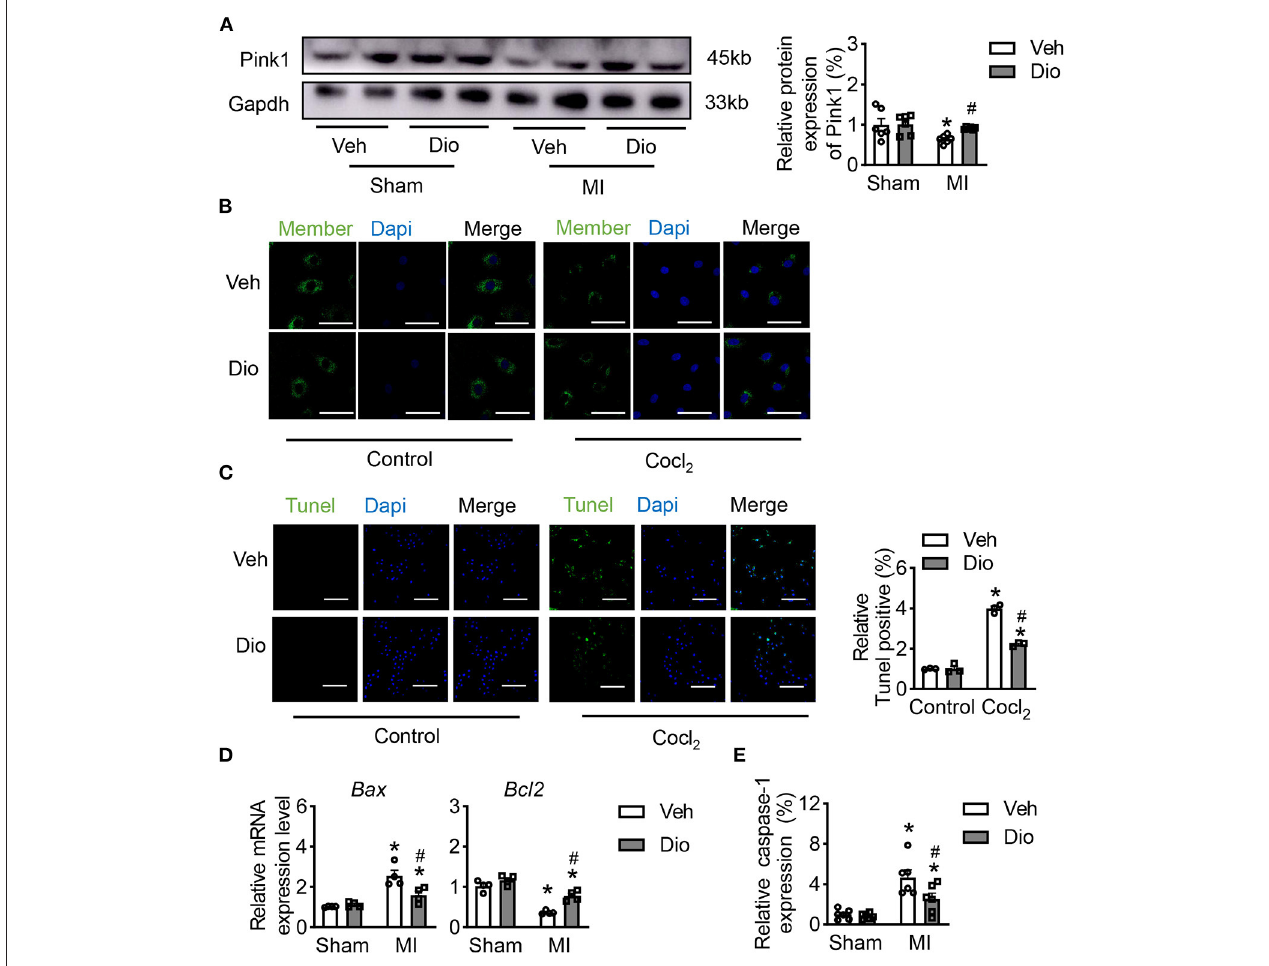
FIGURE 1 | Dioscin alleviates the mitochondrial injury by CoCl2 in H9C2 cells. (A) The protein level of Pink1 in heart tissue ( n = 6). (B) Representative images of the active mitochondrial, bar = 20 µ m ( n = 3). (C) Representative images of TUNEL staining to detect the anti-apoptosis role of dioscin in vitro , bar = 50 µ m ( n = 3). (D) The mRNA level of Bax and Bcl2 in vivo ( n = 4). (E) The measurable of caspase-1 in vivo ( n = 6). Data are mean ± SEM. * P < 0.05 vs. sham group, # P < 0.05 vs. MI